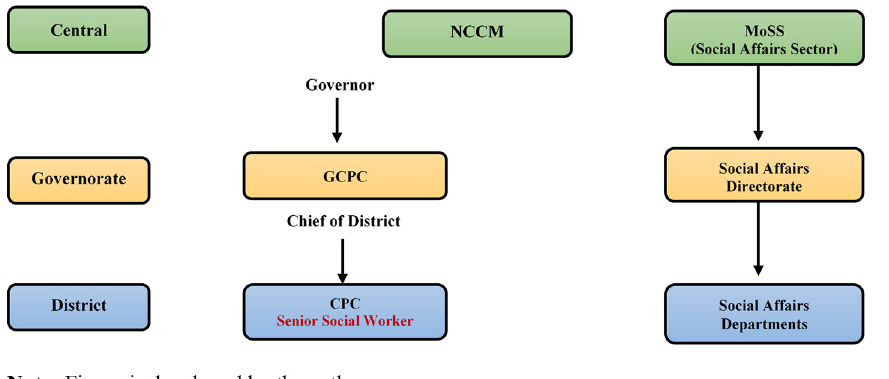
Figure 1. Current